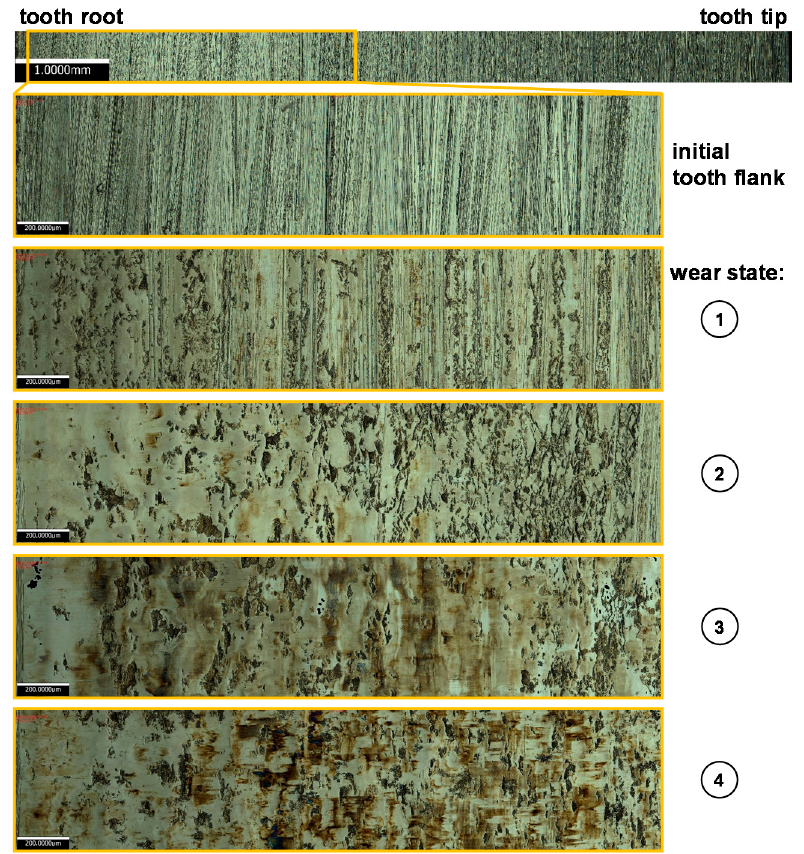
Figure 6. Surface development of gear teeth for the different wear conditions.